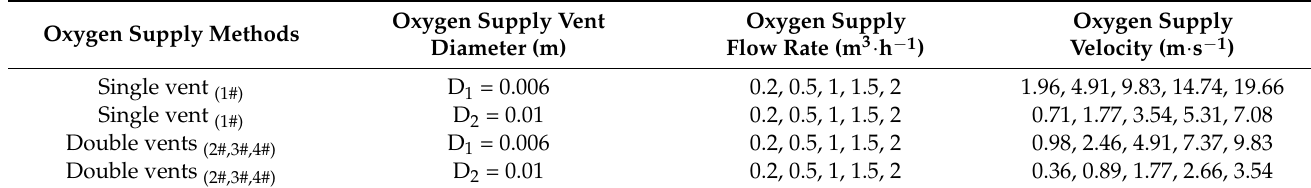
Table 4. Numerical simulation conditions and contents under air-conditioning.